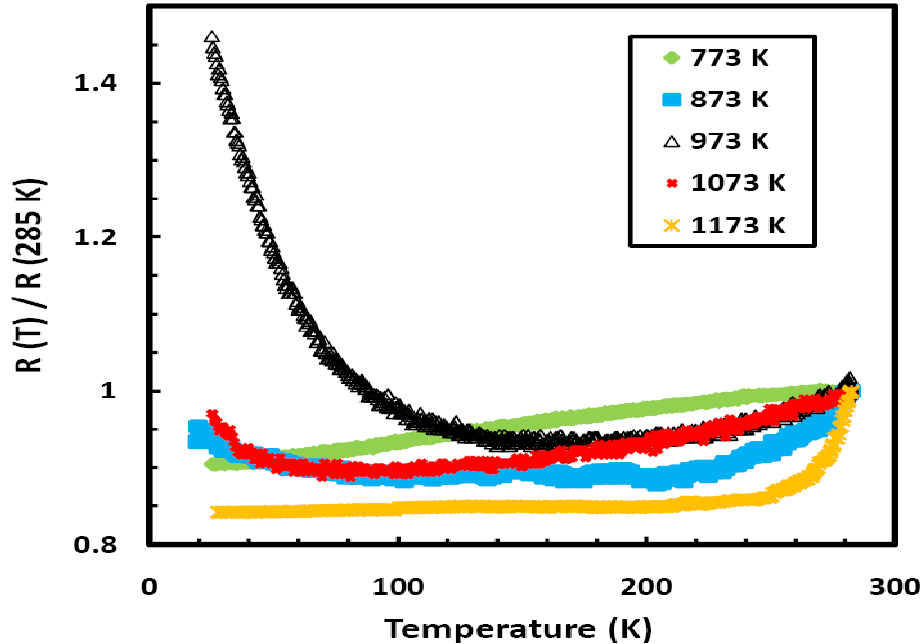
Figure 2. The temperature dependence of the relative resistivity (R(T)/R(285 K)) for different samples of Ni Fe Zr metallic glass annealed over the temperature range 773 0.25 0.75 3 to 1,173 K for the same period of one